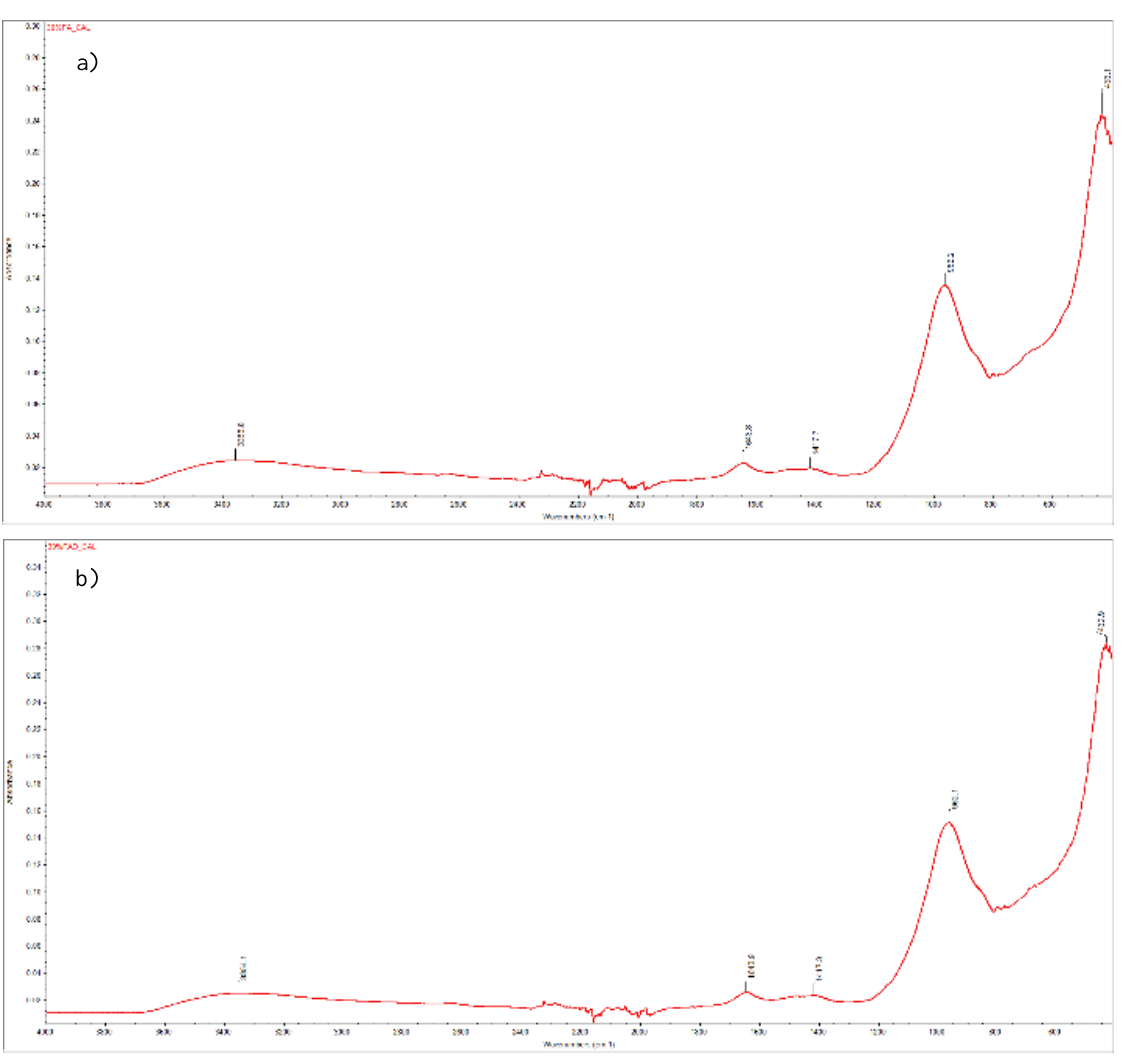
Figure 6. The result of FTIR using a) 30 % FA b) 30 %